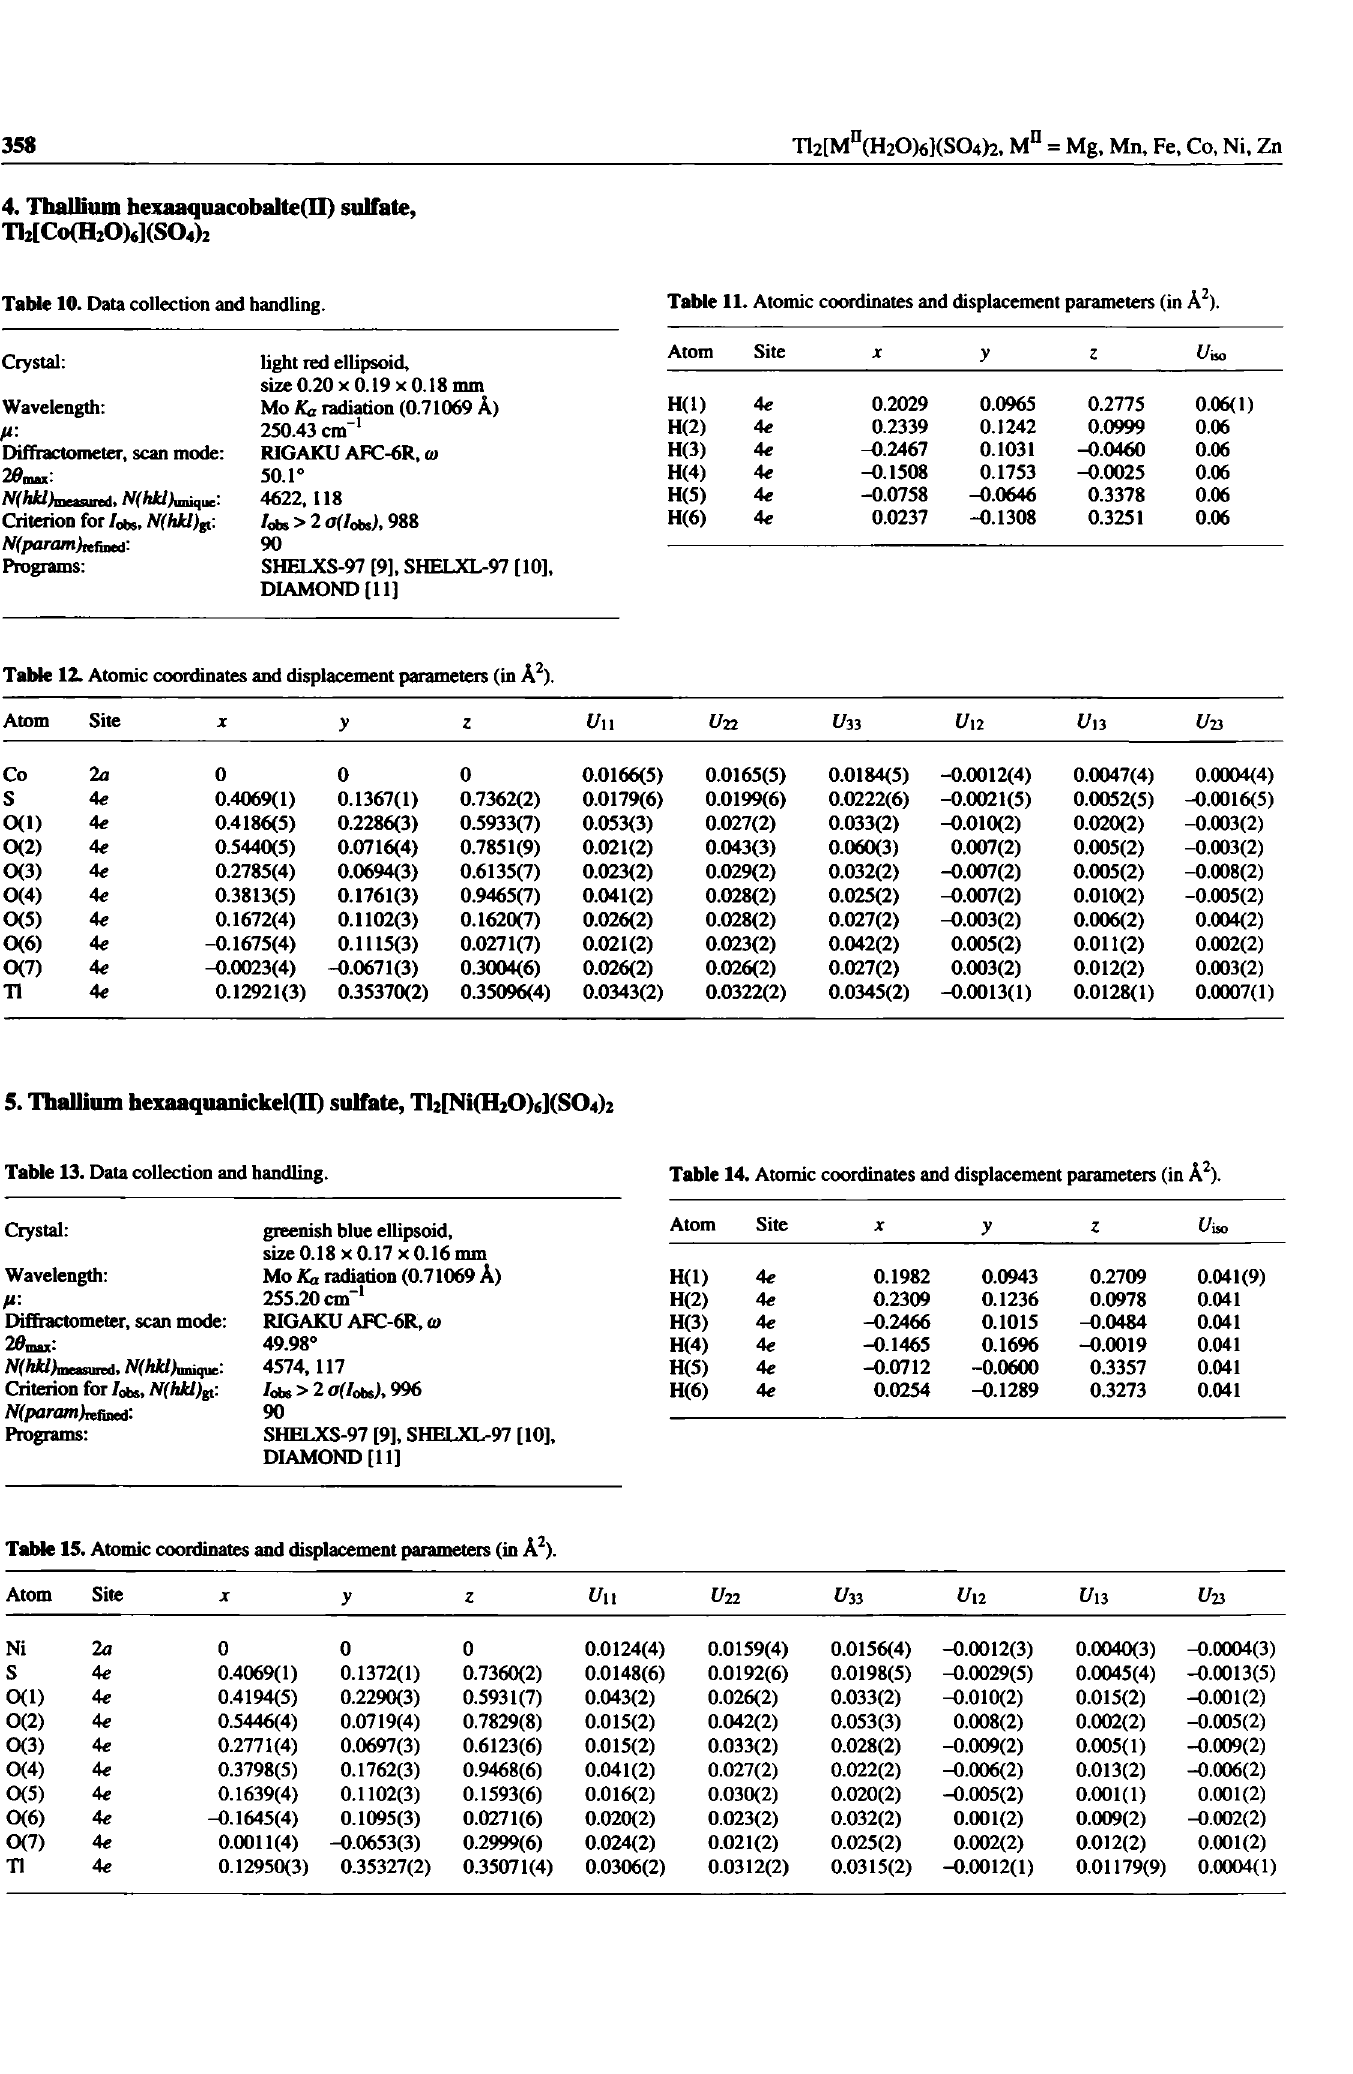
Table 10. Data collection and handling. Table 11. Atomic coordinates and displacement parameters (in À 2 ).